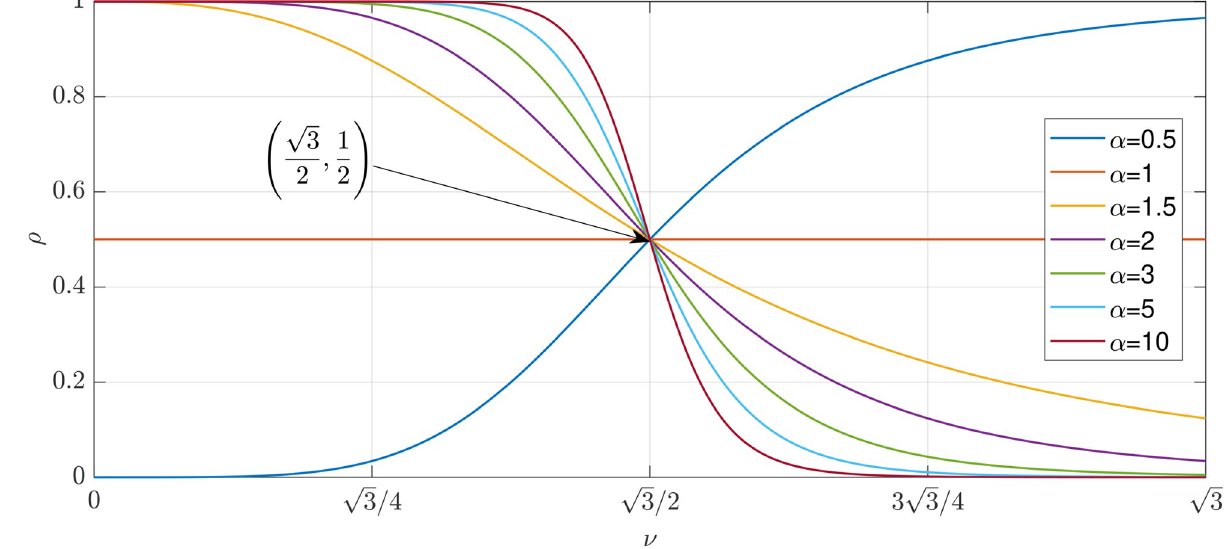
Fig 6. Example of several curves of the monotonic function ρ using several different parameters.